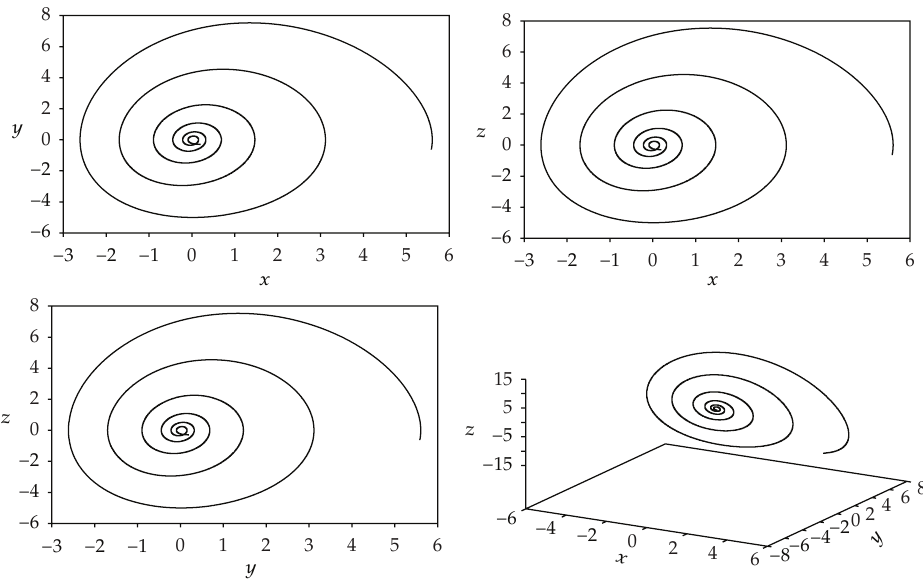
Figure 1: Phase portraits using 10-term MHPM.